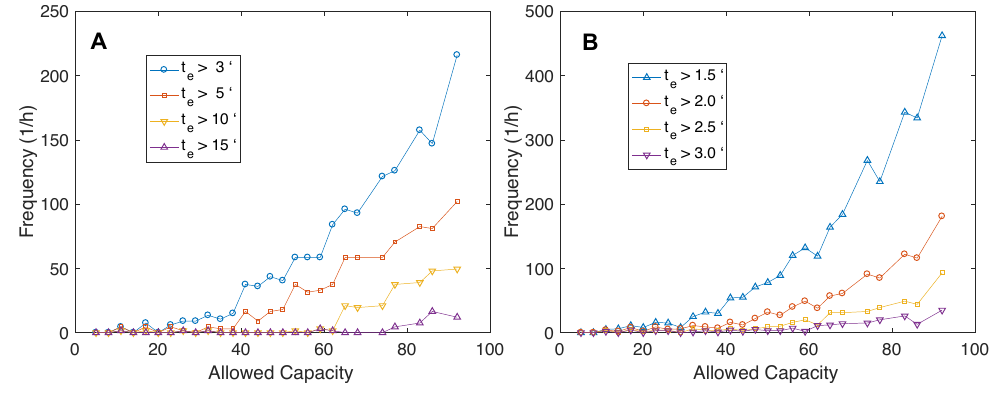
Figure 8: A: Number of events recorded in the first hour of simulations where two agents are at a distance of less than 2 m for more than t e min. B: The same measurement as A but for the second hour of the